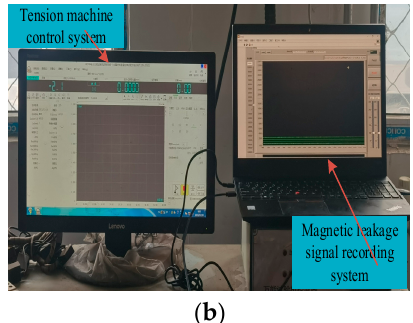
Figure 16. X70 steel strip tensile test device. ( a ) Tensile testing machine. ( b ) Software control systems and signal acquisition systems.